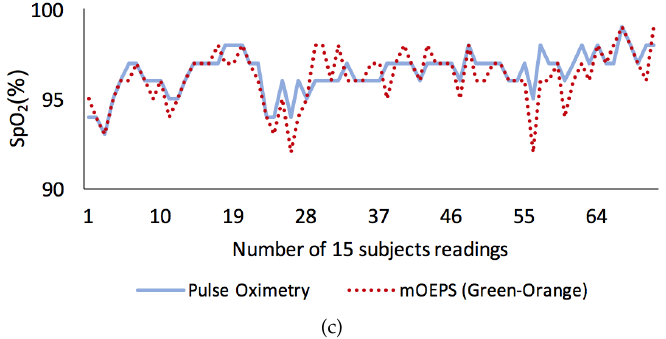
Figure 6. SpO 2 data obtained from the mOEPS and a standard pulse oximetry device. The graphs of ( a – c ) display a line correlation for subject I, subject II and all 15 subjects respectively.